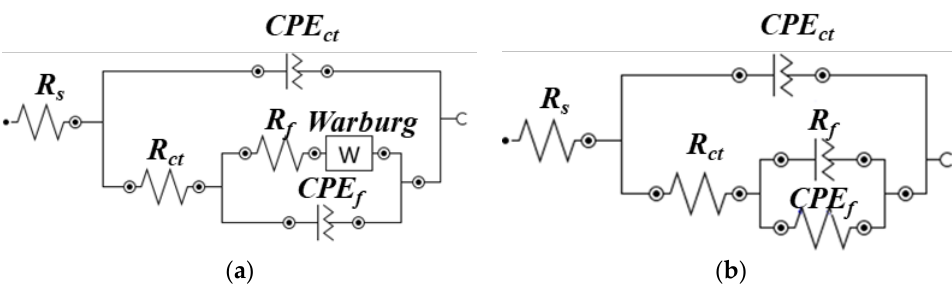
Figure 9. EEC of coatings after ( a ) 1 h and ( b ) 1 d – 23 d of exposure to artificial seawater.